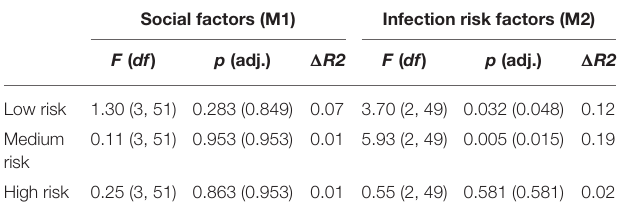
The “Social Factors” model served as baseline model and contained the three factor scores representing individual differences in the general frequency of social interactions, liking of interaction at work and with family, liking of interactions with friends, and liking of social interaction during leisure time. The “Infection Risk Factors” model additionally included two variables representing the perceived short-term or long-term probability of infection with SARS-CoV-2. Adj.: adjusted p-value after Benjamini-Hochberg-correction for comparison between the three